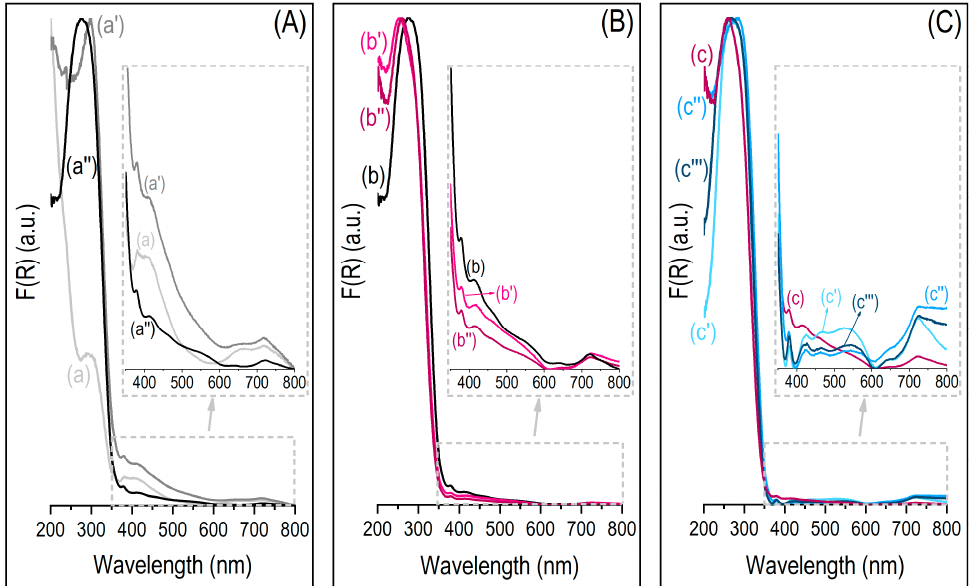
Figure 3. DRS UV-Vis spectra collected for: ( A ) Ni loading samples: ( a ) 5Ni/USY(3), ( a ′ ) 10Ni/USY(3), and ( a ″ ) 15Ni/USY(3); ( B ) Si/Al ratio samples: ( b ) 15Ni/USY(3), ( b ′ ) 15Ni/USY(15),